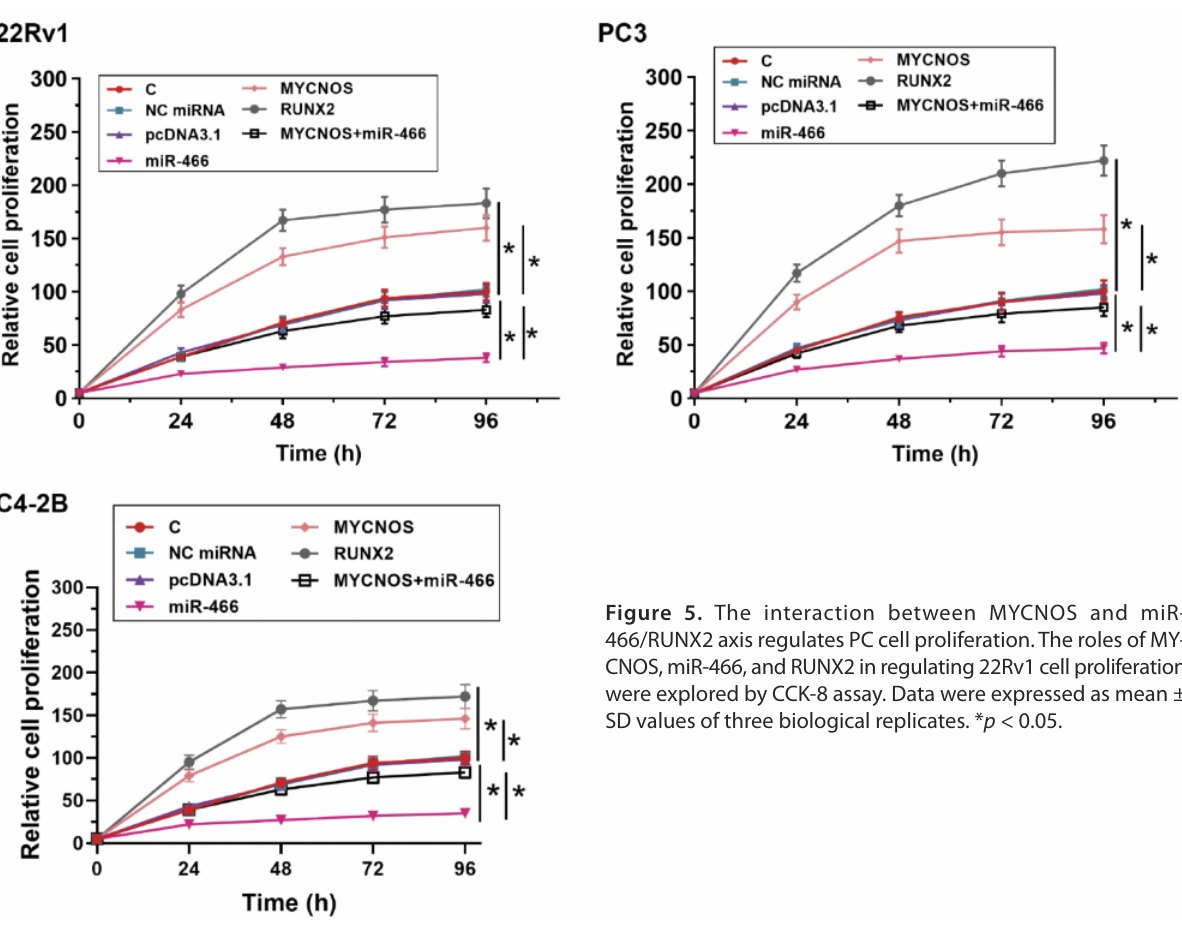
Figure 5. The interaction between MYCNOS and miR- 466/RUNX2 axis regulates PC cell proliferation. The roles of MY- CNOS, miR-466, and RUNX2 in regulating 22Rv1 cell proliferation were explored by CCK-8 assay. Data were expressed as mean ± SD values of three biological replicates. * p <